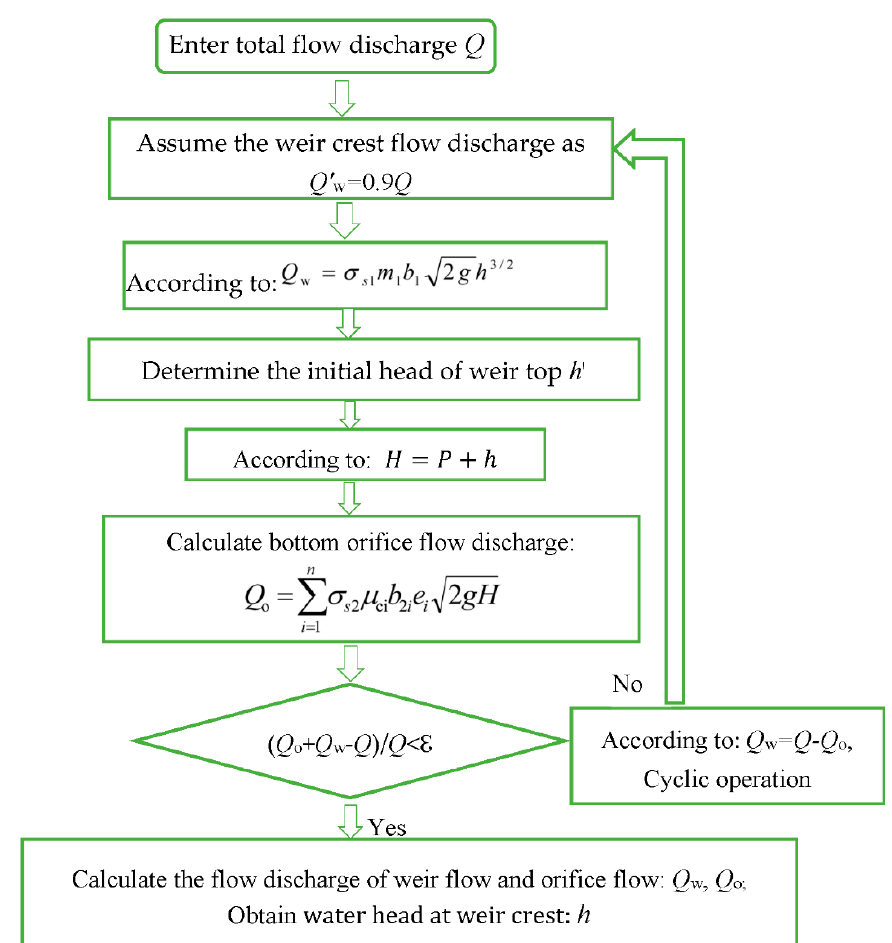
Figure 4. Hydraulic computing process of the DWO. The program shows a method to calculate the respective discharge of the weir flow and orifice flow considering the needs of fish migration.